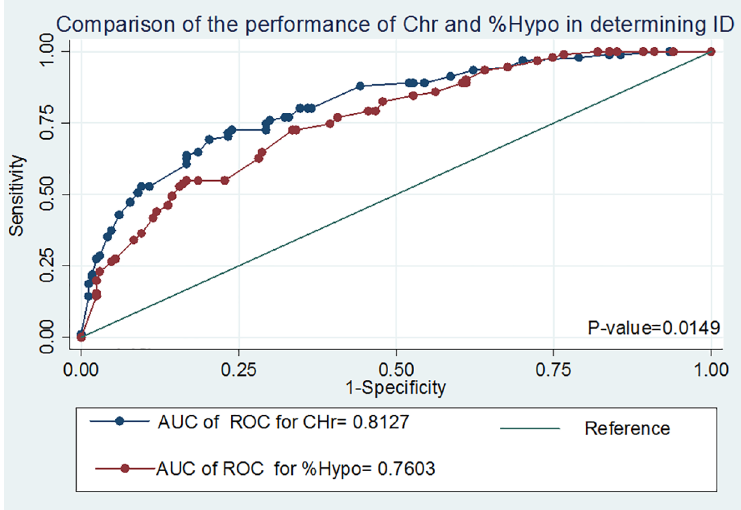
Fig 2. Comparison of the receiver operator characteristics (ROC) of reticulocyte haemoglobin content (CHr) and percentage hypochromic red cells.